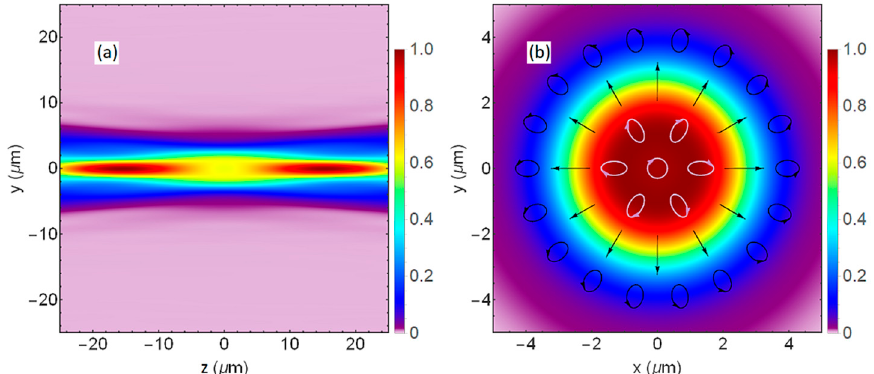
Figure 8. Intensity profile near the focal plane for variation 2 of the system, using the aspheric lens with the lower numerical aperture ( a ); intensity profile and polarization state in the focal plane ( b ).